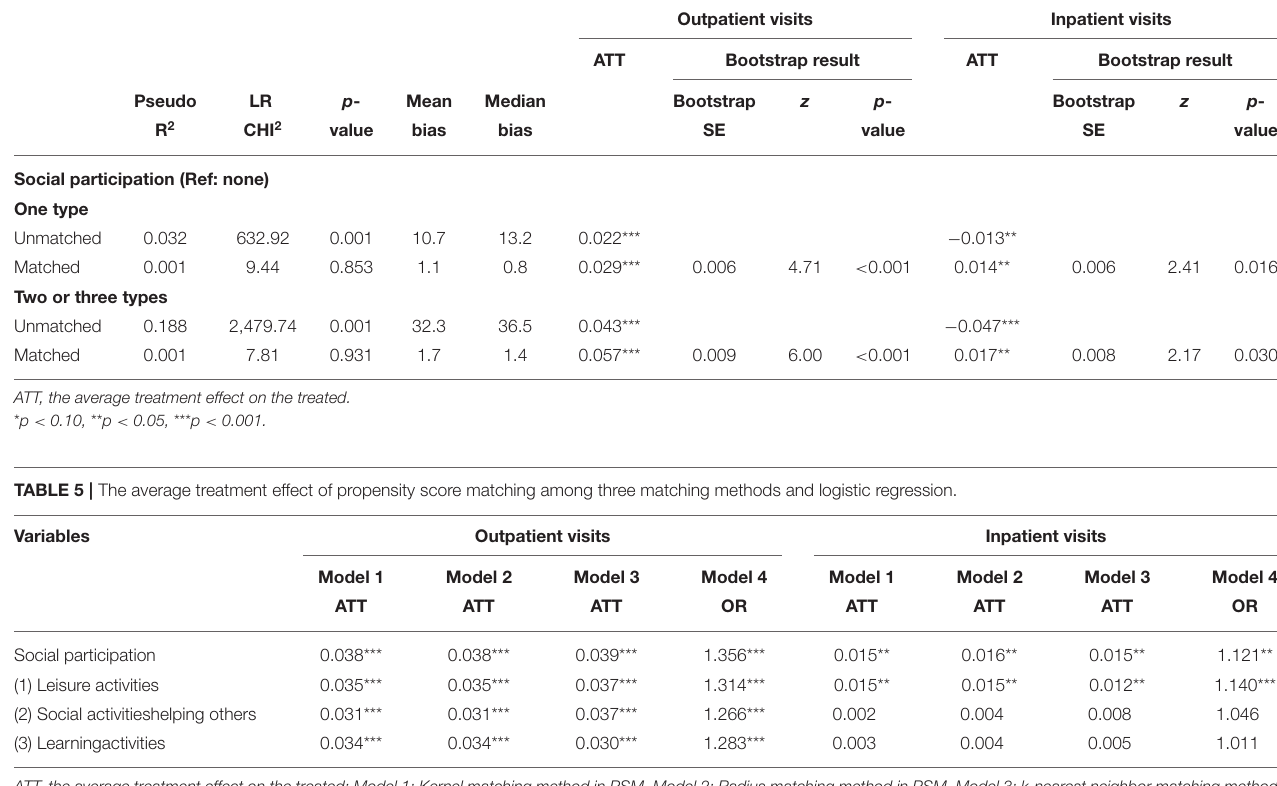
TABLE 4 | Overall balance t -test and propensity score matched results and combined effect of each type of social participation. Variables